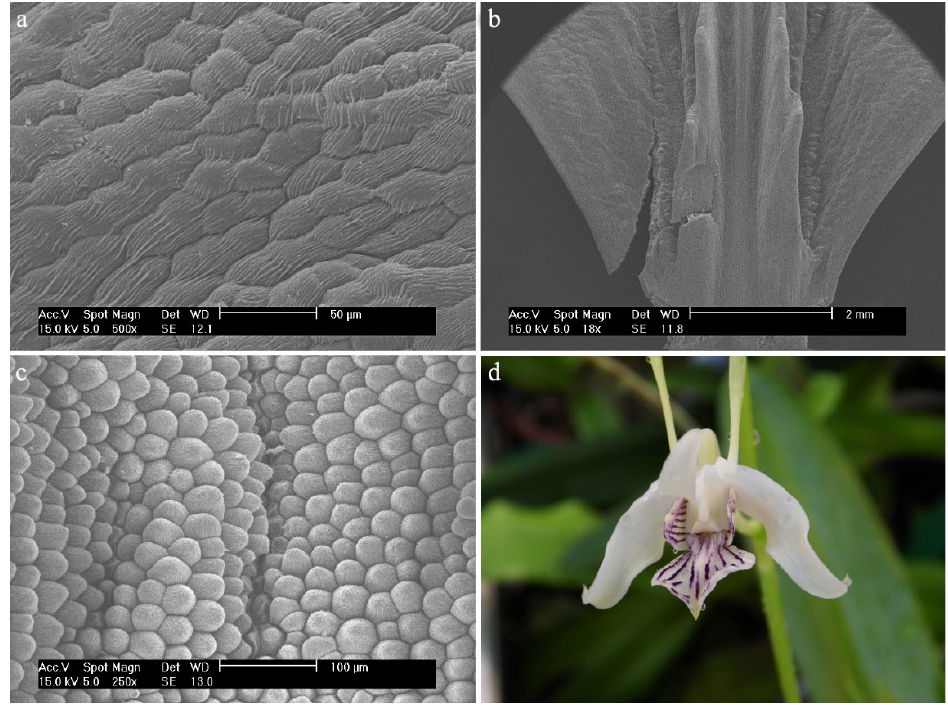
Figure 21. Dendrobium attenuatum Lindl.: ( a ) the mesochile part of the labellum; ( b ) the hypochile part of the labellum; ( c ) the epichile part of the labellum; ( d ) flower (photo by Monika Lipi ń ska).